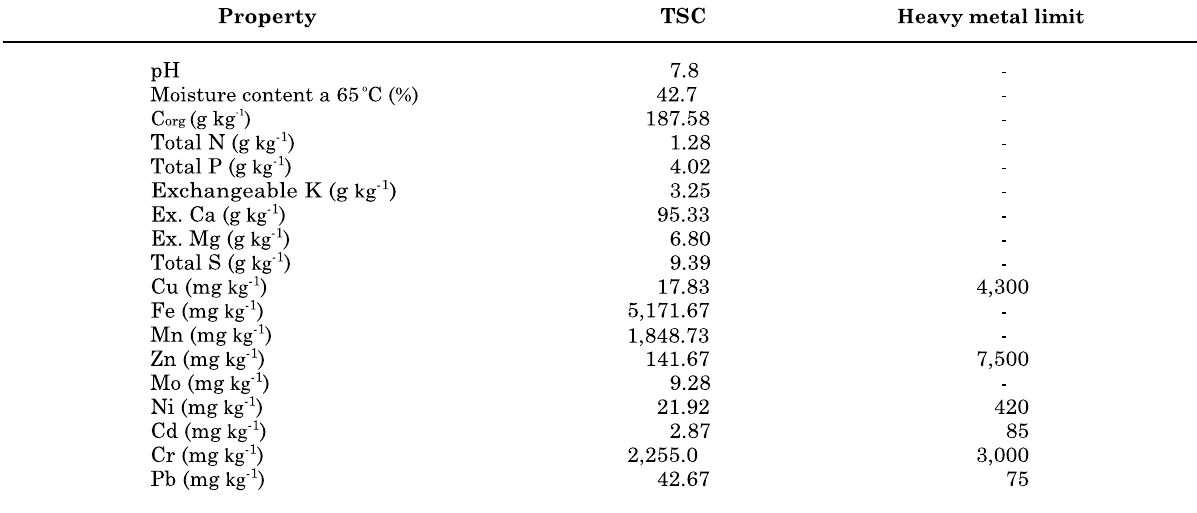
Table 1. Chemical properties of composted dry tannery sludge (TSC)